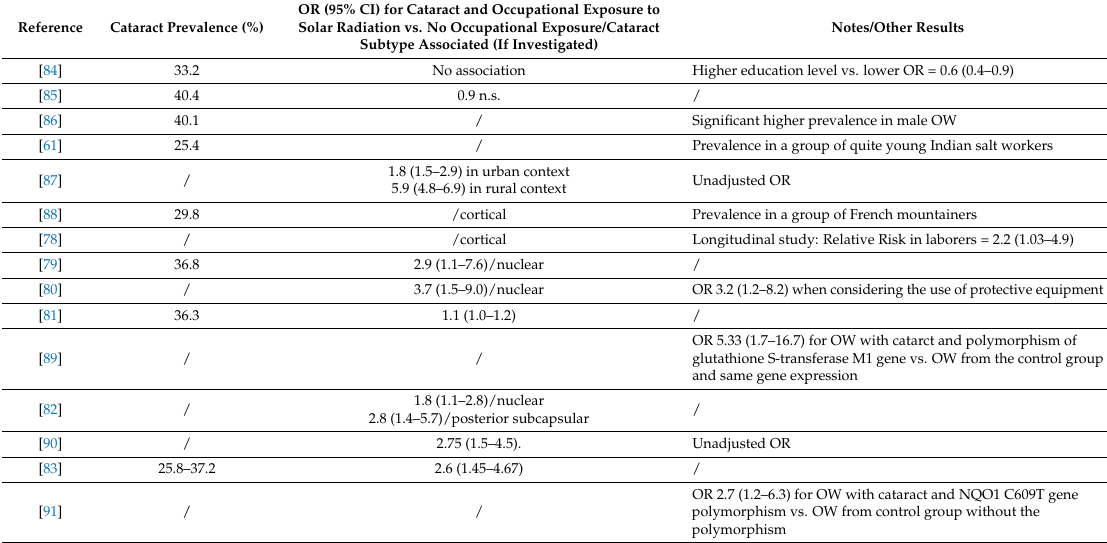
Table 5. Cataract prevalence and mean ORs calculated in scientific studies conducted in outdoor workers (OW) in the period of 1998 to 2017 (adapted from Modenese and Gobba, 2018)